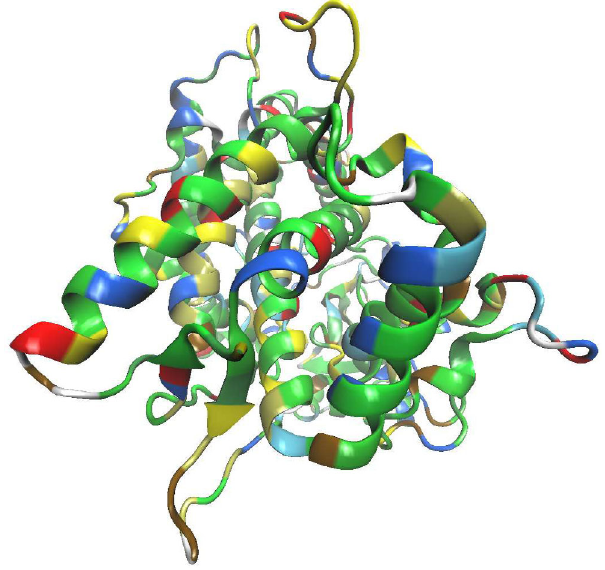
Fig. 1 Structure of human microsomal CYP450 1A2 enzyme. Evaluating the possibility of inhibiting this enzyme by drug candidates is one of the early steps in drug